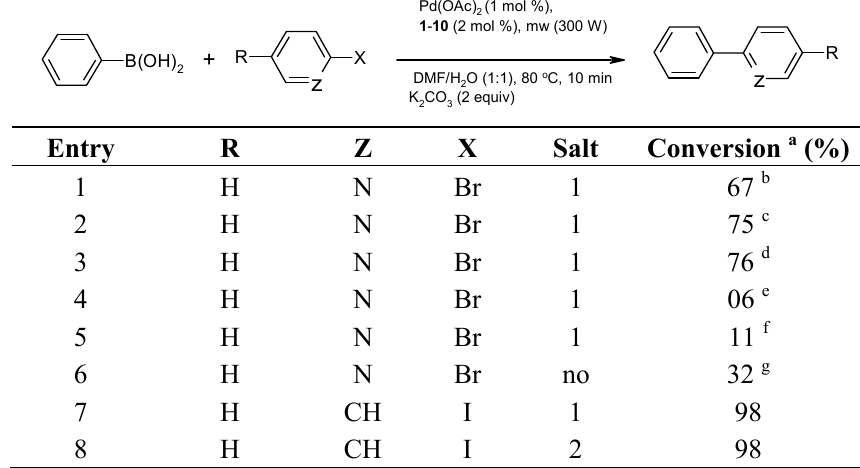
Table 4. The Suzuki-Miyaura coupling reactions of aryl halides with phenylboronic acid. B(OH)